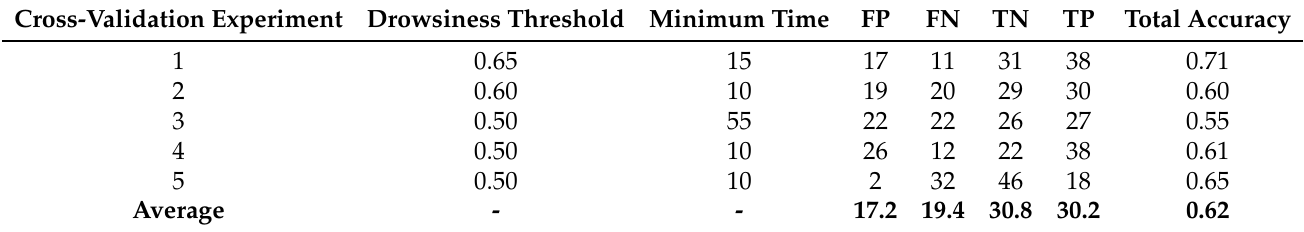
Table 5. Cross-validation of the results obtained by Alternative I over train data.